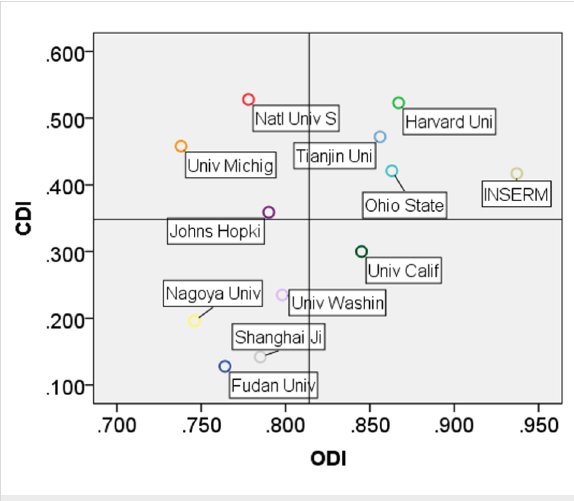
Figure 5: Collaboration activity of the top 12